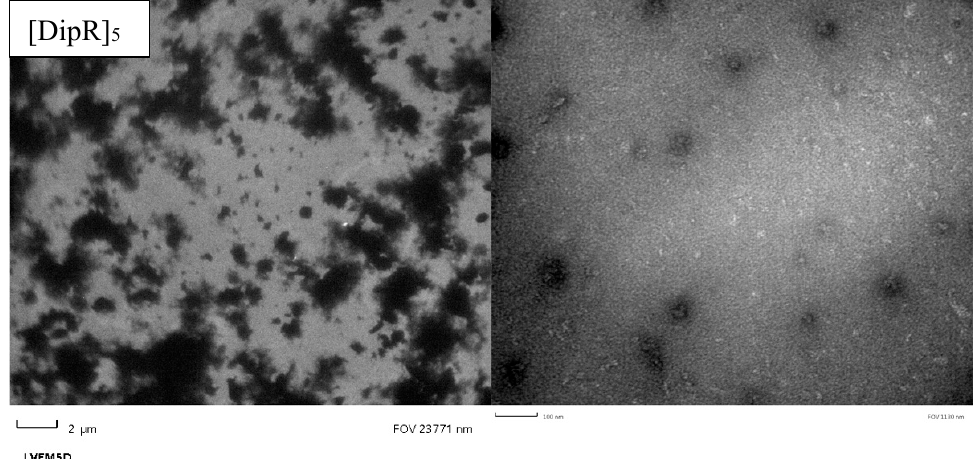
Figure 12. Transmission electron microscopy images of [(DipR)(WR) 4 ], R(DipR) 4 , and [DipR] 5 (different magnifications of left 2 µm and right 100 nm).